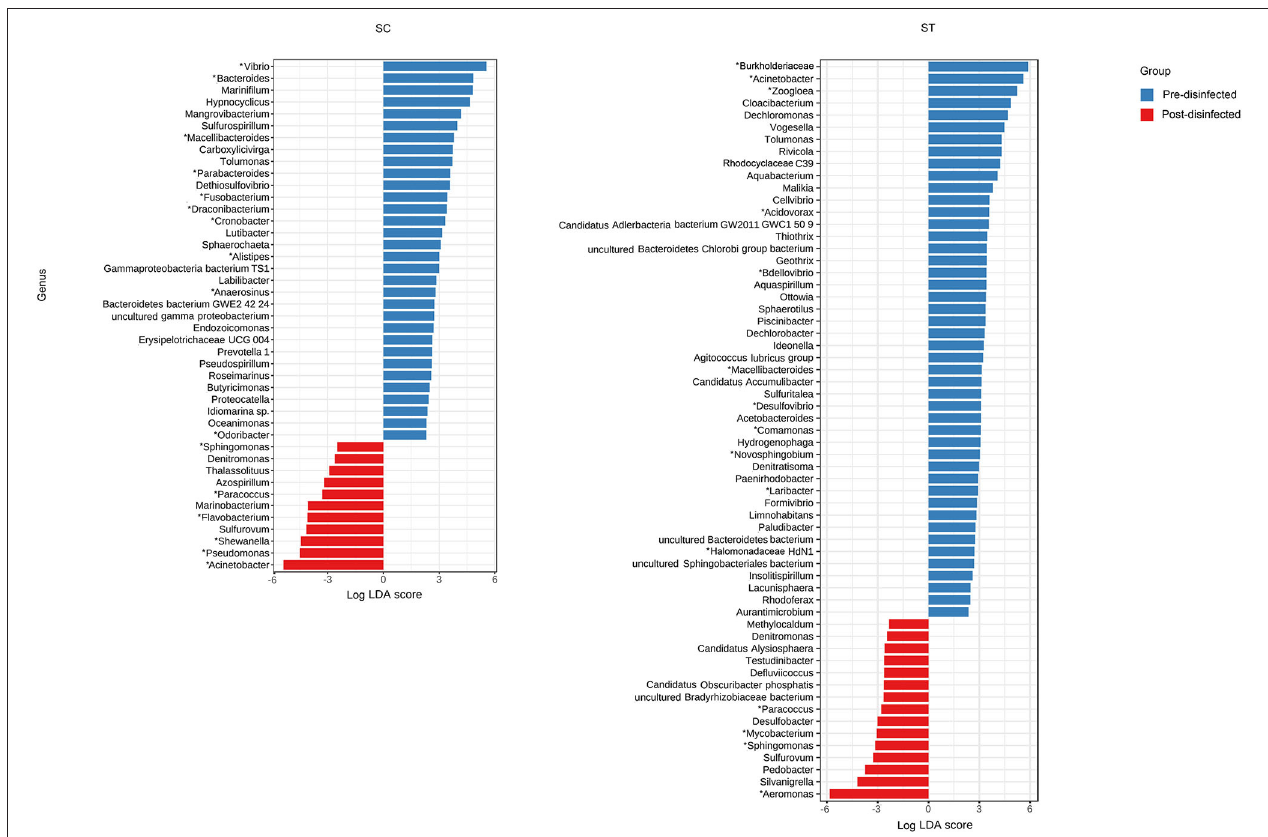
FIGURE 3 | Linear Discriminant Analysis Effect Size (LEfSe) plot of significantly discriminative genera identified in the viable populations of effluents in SC and ST (Kruskal–Wallis sum-rank test, q < 0.05, absolute log LDA score > 2). Absolute LDA score indicates the discriminatory power of the genus in the dedicated group. Genera with reported pathogenic species were marked with